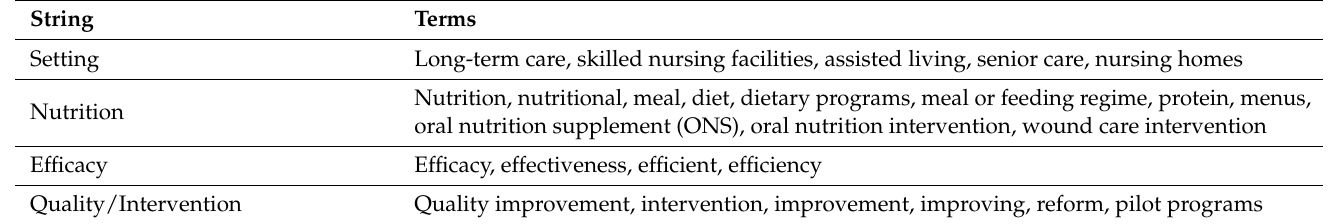
Table 2. Key search terms for research review of malnutrition and nutrition-focused quality improvement programs (QIPs) and quality effectiveness process initiatives in skilled nursing facilities (SNFs).